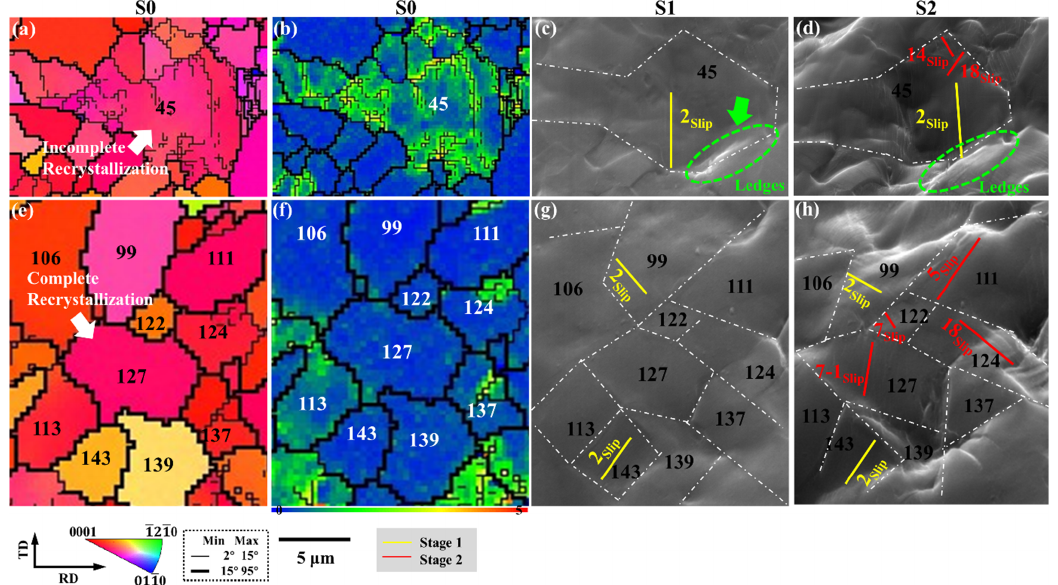
Figure 6. The plastic behavior of complete recrystallization and incomplete recrystallization during uniaxial stretching: ( a , e ) IPF images; ( b , f ) KAM images; and ( c , d , g , h ) SEM images at different strain stages. The slip system represented by the slip traces in the figure is shown in Figure 7.